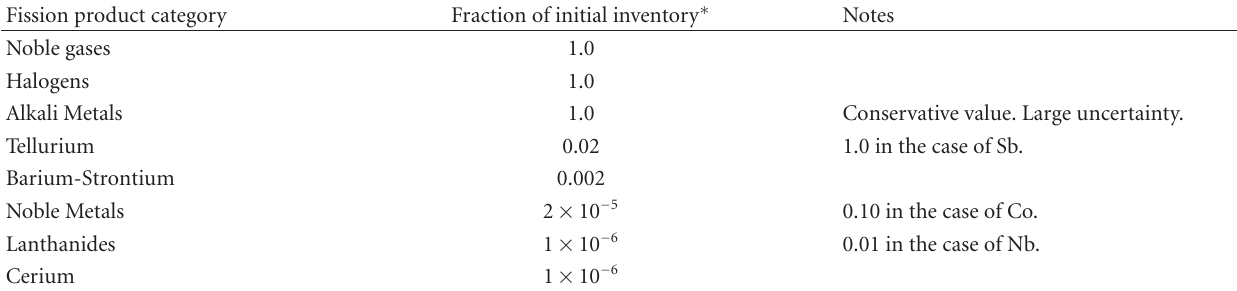
Table 5: Fraction of radioactivity release from spent fuel pool to reactor building following “zirconium-fire” (NUREG 4982, 1987). Fission product